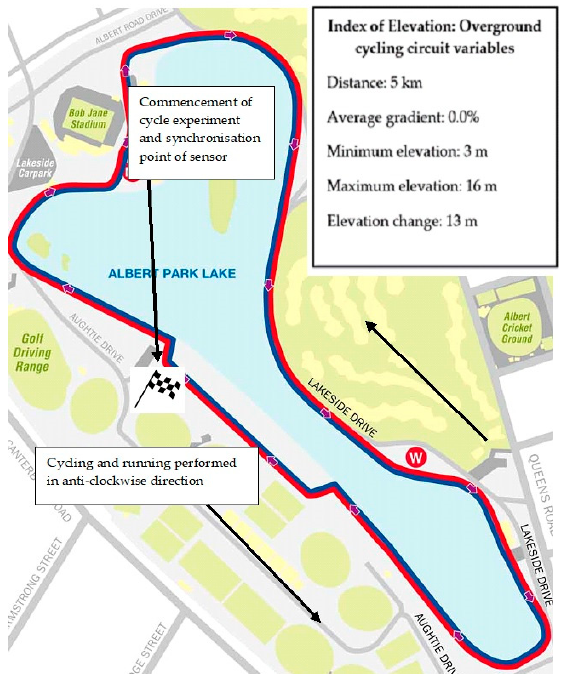
Figure 2. Map view and location of both experiments. The index of elevation contains the course variables experienced by the participants during both experiments. The average gradient across the 5 km circuit was 0%. 5 km circuit was